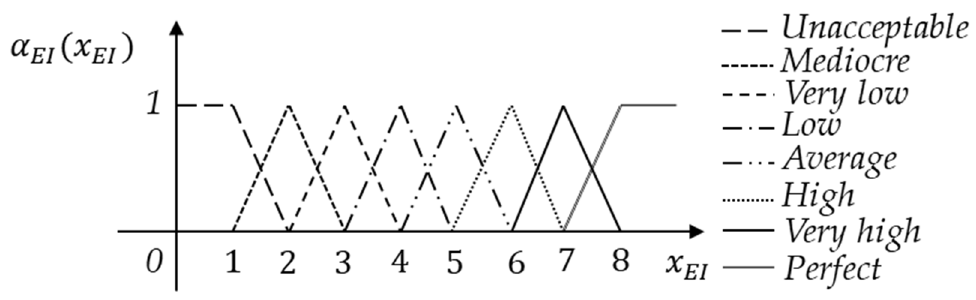
Figure 8. The membership function of the output variable evaluation of the waste treatment system.